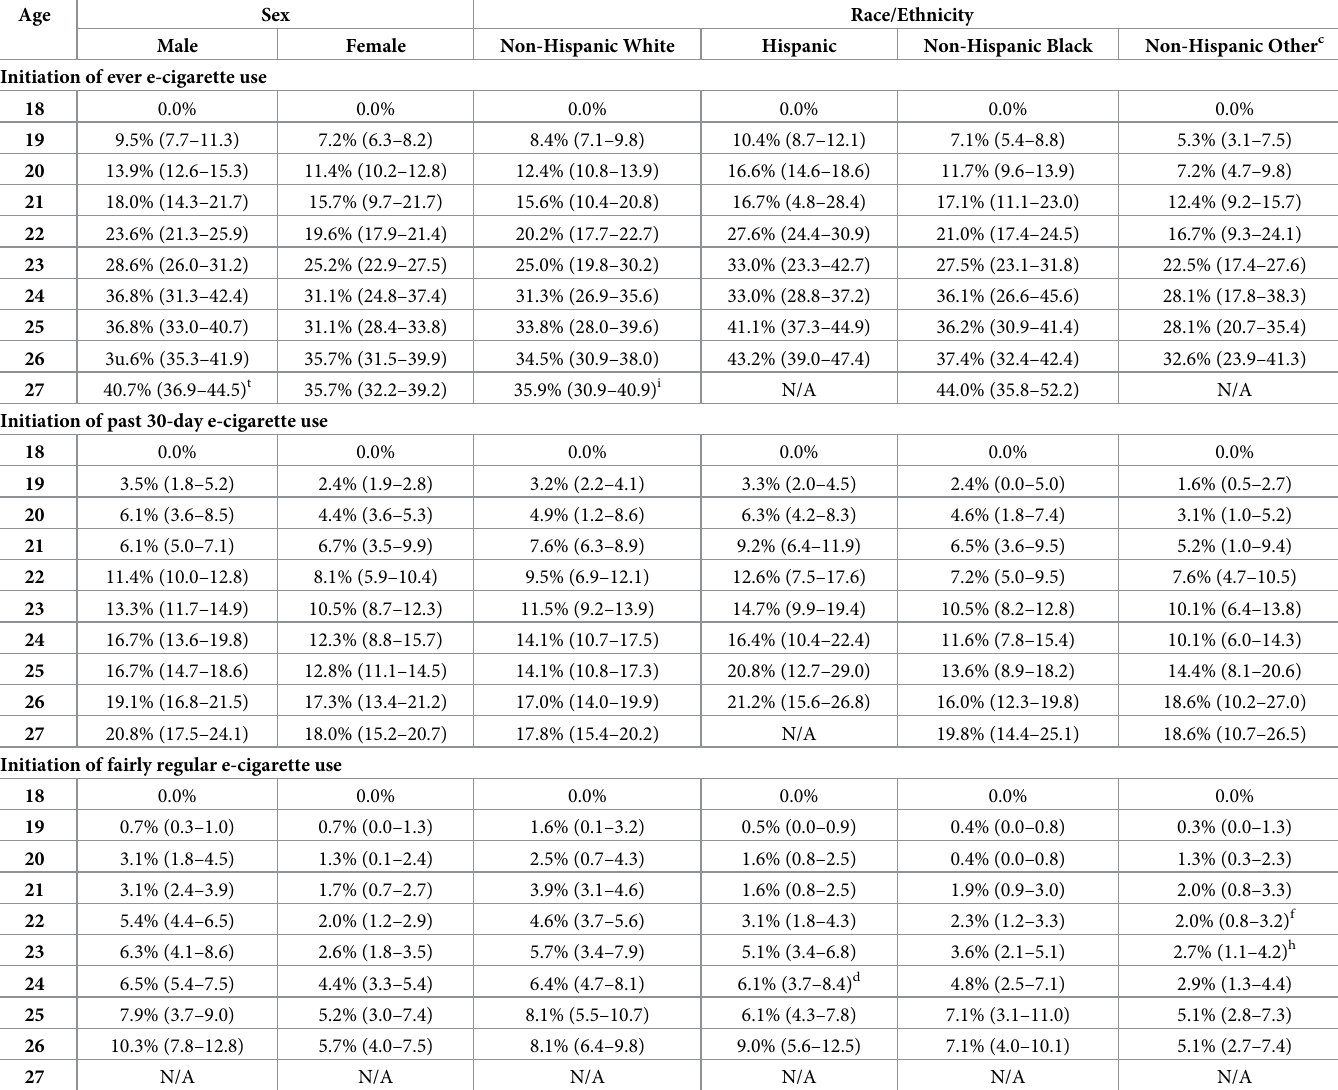
Table 4. Estimated hazard functions a and 95%CIs a of the age of e-cigarette initiation outcomes for PATH b USA young adults by sex and by